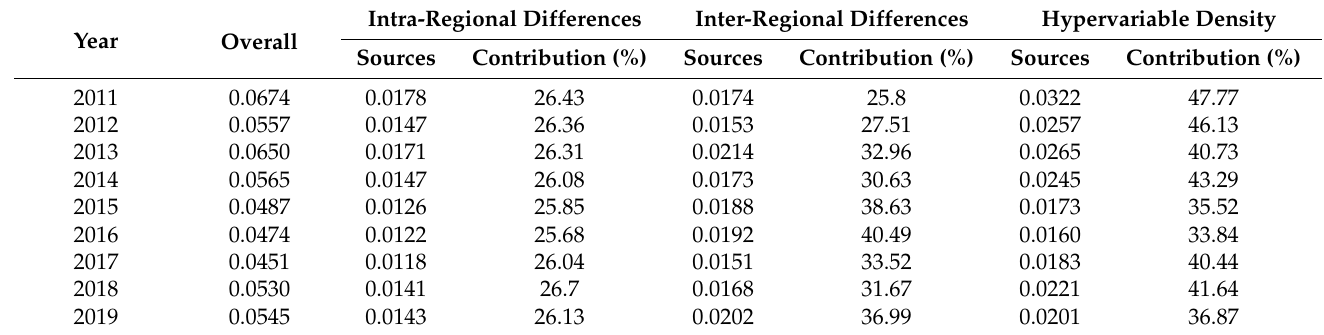
Table 3. Sources and contributions of overall differences in China’s CD&GDD from 2011 to